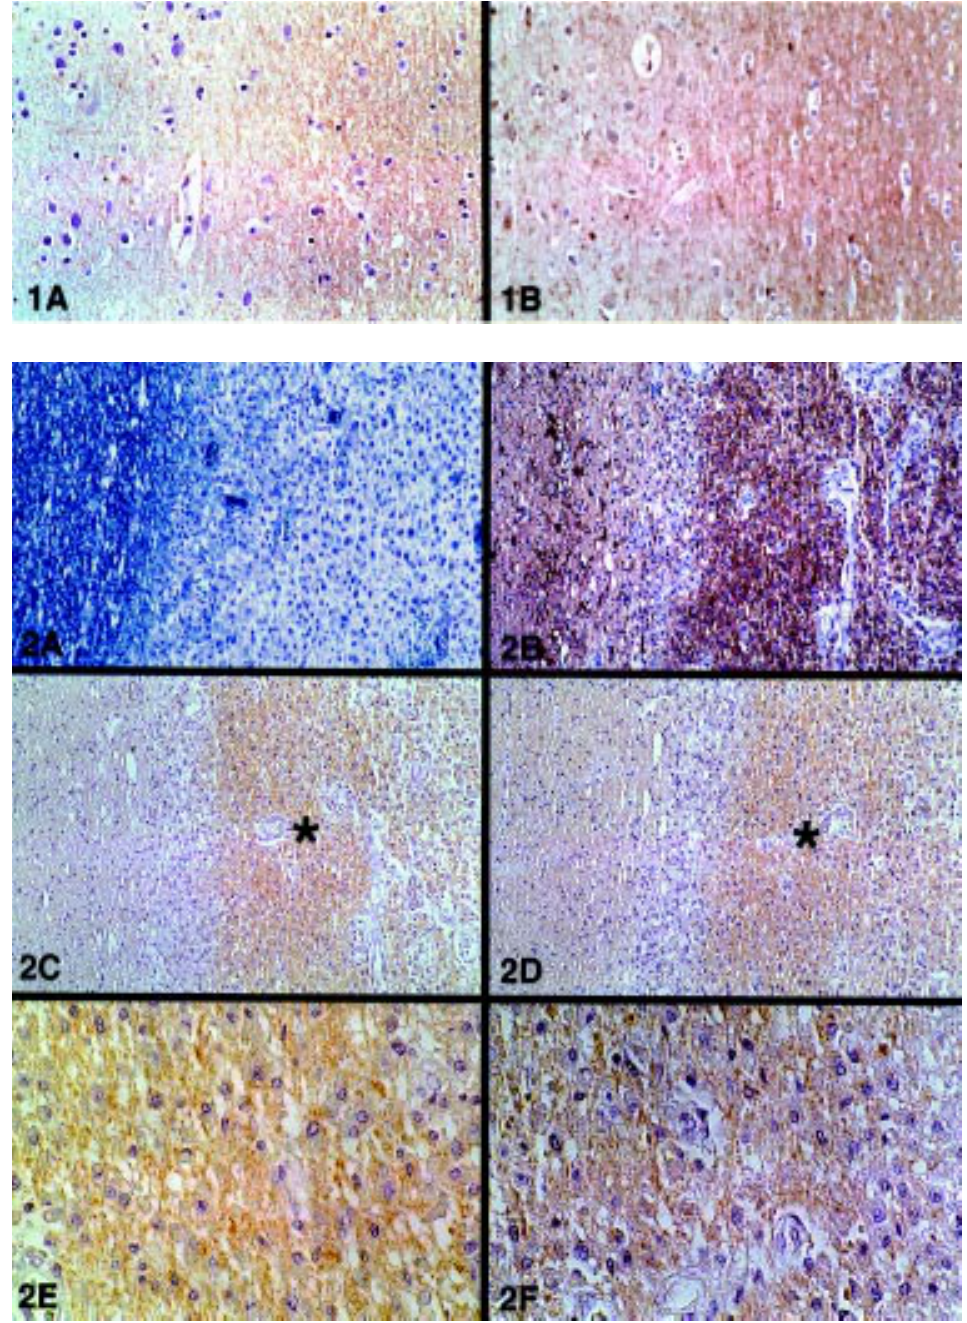
Figure 2. Versican and dermatan sulfate proteoglycan at the edges of an active MS lesion. Serial par- affin sections of brain white mat- ter of an active MS lesion are stained with Klüver-Barrera stain for myelin (A) or immunostained with antibody to glial fibrillary acidic protein (B), versican (C, E), or dermatan sulfate proteoglycan (D, F). In A - D , intact white matter is on the left side of each field; a hypercellular vertical band in the middle of the field is the plaque edge, and the plaque center is on the right. In A , intact myelin is blue and the hypercellular area and plaque areas show loss of blue staining indicating demyeli- nation. In B , there are individual dark staining reactive astrocytes in the intact white matter on the left and there is a diffuse increase in glial fibrillary acidic protein im- munostaining in the plaque edge and center indicating astrocyto- sis. In C and D , there is pale stain- ing of the intact white matter on the left and a zone of decreased staining corresponding to the hy- percellular inflammatory plaque edge. In the middle, there is a band of increased ECM versican (C) and dermatan sulfate proteo- glycan (D) staining (asterisks). This staining is less intense on the right, in the plaque center. Panels E and F show higher power of the indicated areas of increased ECM versican and der- matan sulfate proteoglycan stain- ing. Magnification = 130X (A-D), 430X (E,